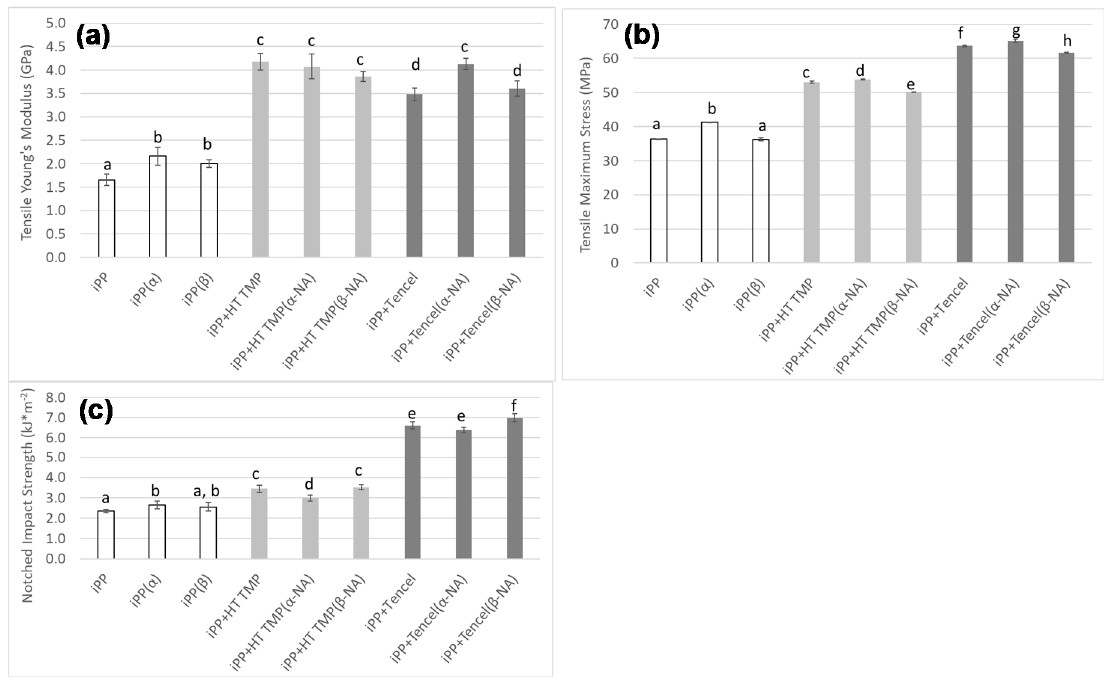
Figure 4. Influence of the α - and β -NA and HT TMP and Tencel™ fibres on ( a ) Young’s modulus, ( b ) tensile maximum stress, and ( c ) notched impact strength. (Anova: different letter indicates significant difference at α = 0.05).